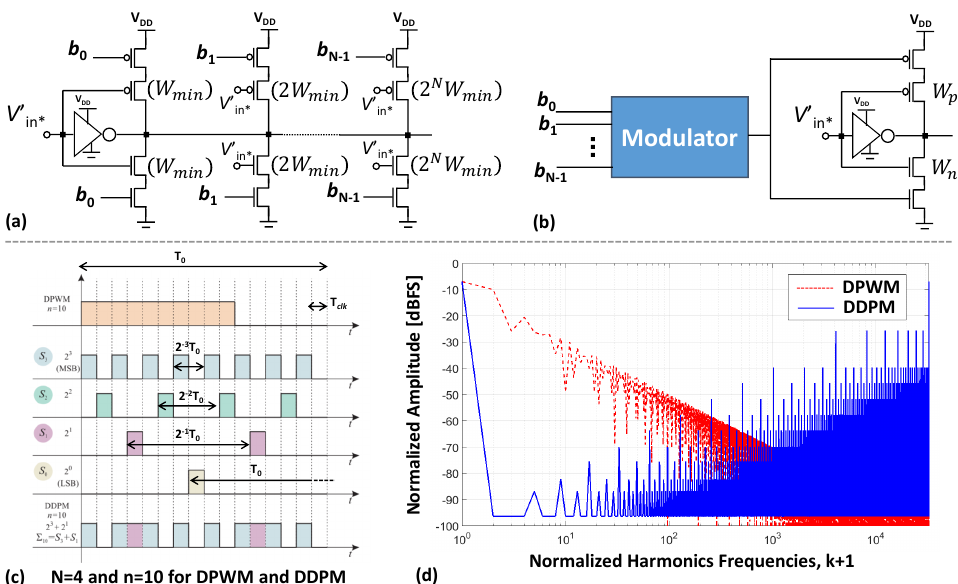
Figure 3. ( a ) N-bit static calibration ( b ) N-bit dynamic calibration ( c ) DDPM and DPPM waveforms for N = 4 and n = 10 ( d ) Normalized DPWM and DPPM spectrum for N = 16 and n =